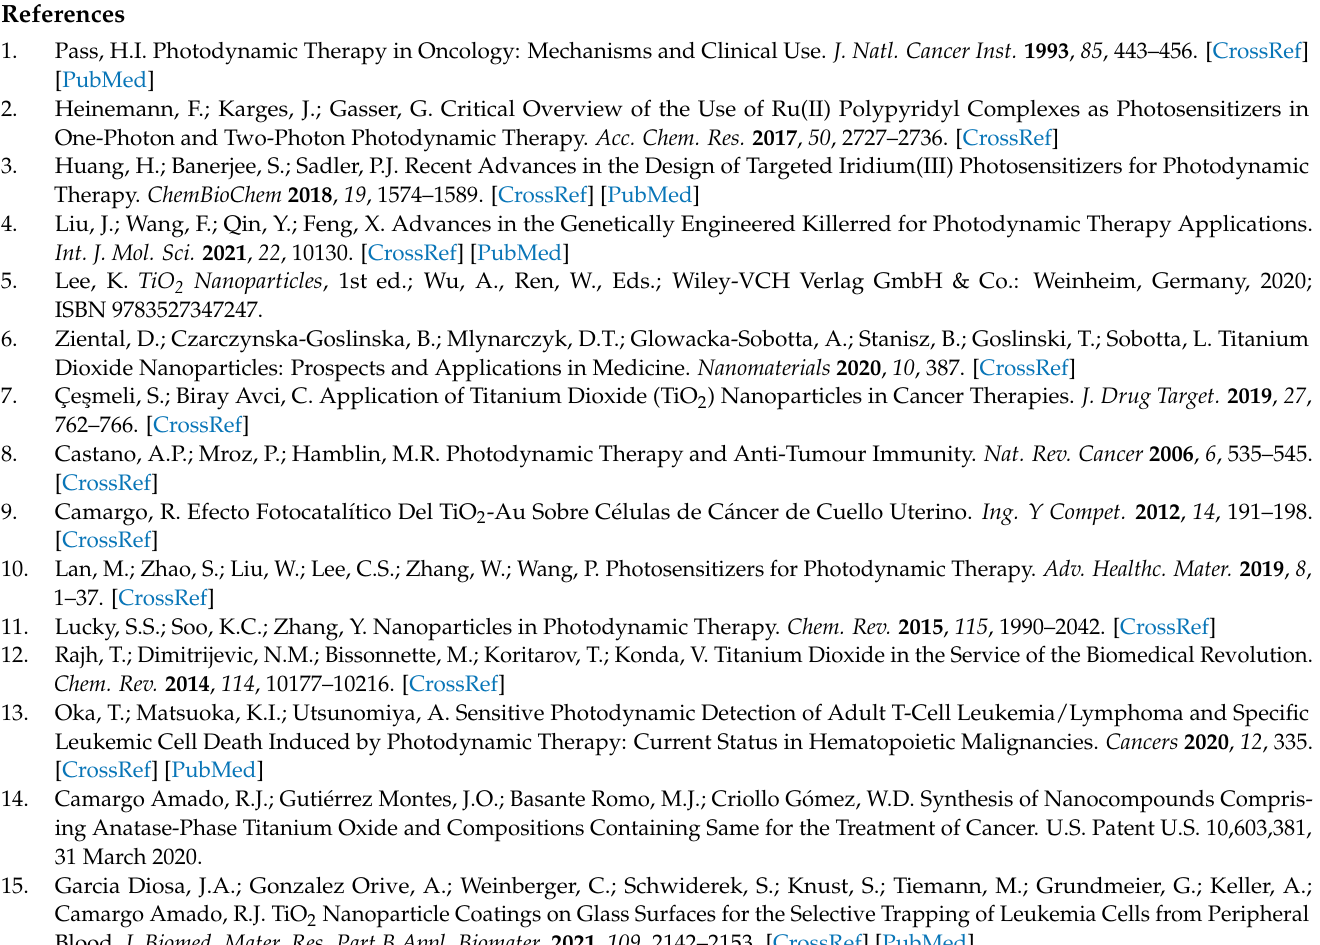
coating for 60 min, Figure S7: Representative AFM images of single MOLT4 cells on glass surfaces and corresponding masks used in the analysis of cell shapes, Figure S8: Representative AFM images of single MOLT4 cells cultured on TiO 2 -m coatings for 10 min and corresponding masks used in the analysis of cell shapes, Figure S9: Representative AFM images of single MOLT4 cells cultured on TiO 2 -m coatings for 20 min and corresponding masks used in the analysis of cell shapes, Figure S10: Representative AFM images of single MOLT4 cells cultured on TiO 2 -m coatings for 40 min and corresponding masks used in the analysis of cell shapes, Figure S11: Representative AFM images of single MOLT4 cells cultured on TiO 2 -m coatings for 60 min and corresponding masks used in the analysis of cell